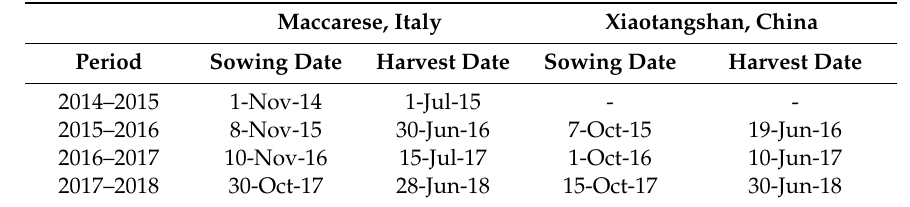
Table 2. Sowing and harvest dates for test sites.